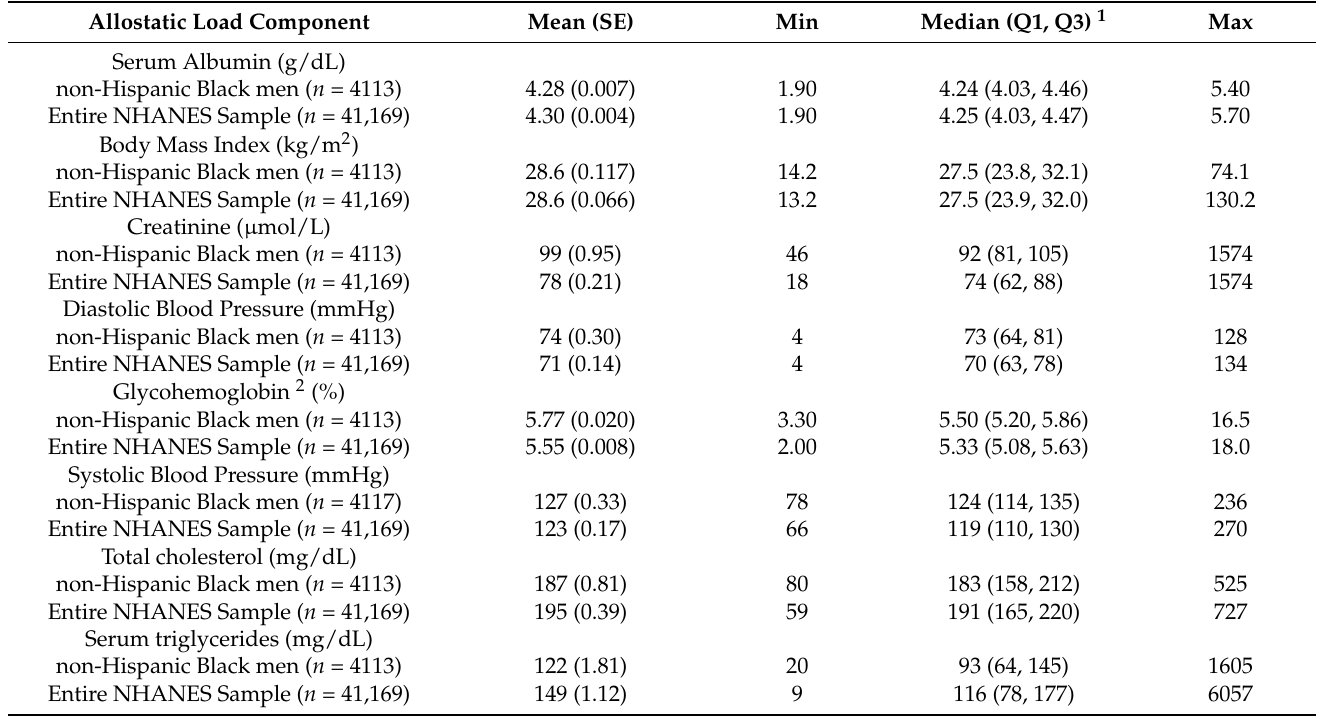
Table A1. Weighted distribution of allostatic load components comparing subsample of non-Hispanic Black men vs. entire NHANES